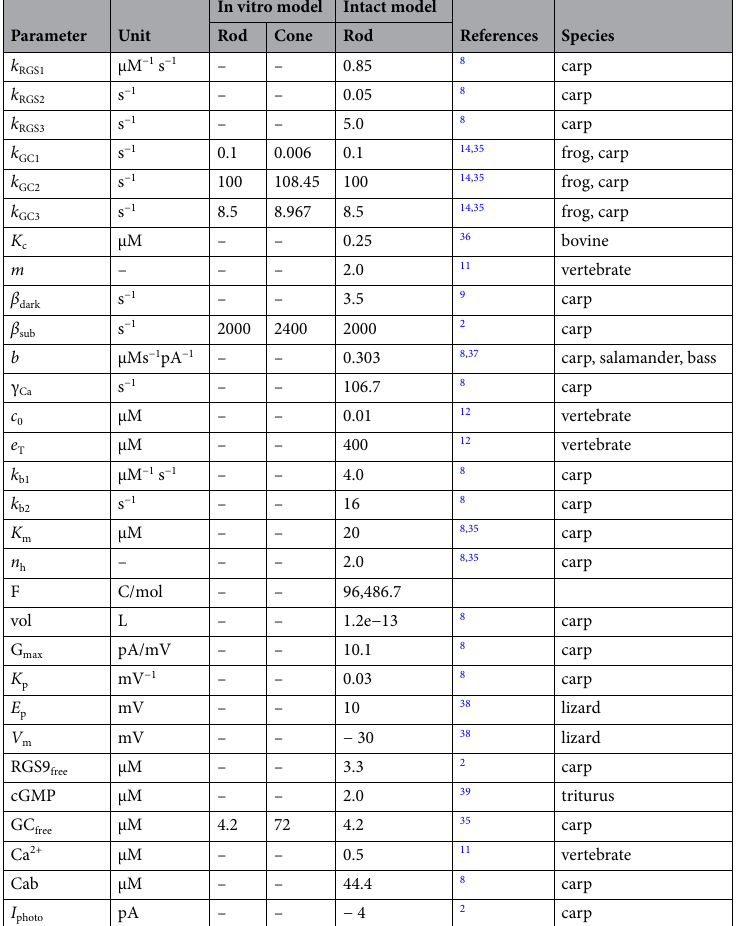
Table 5. Parameters in the intact